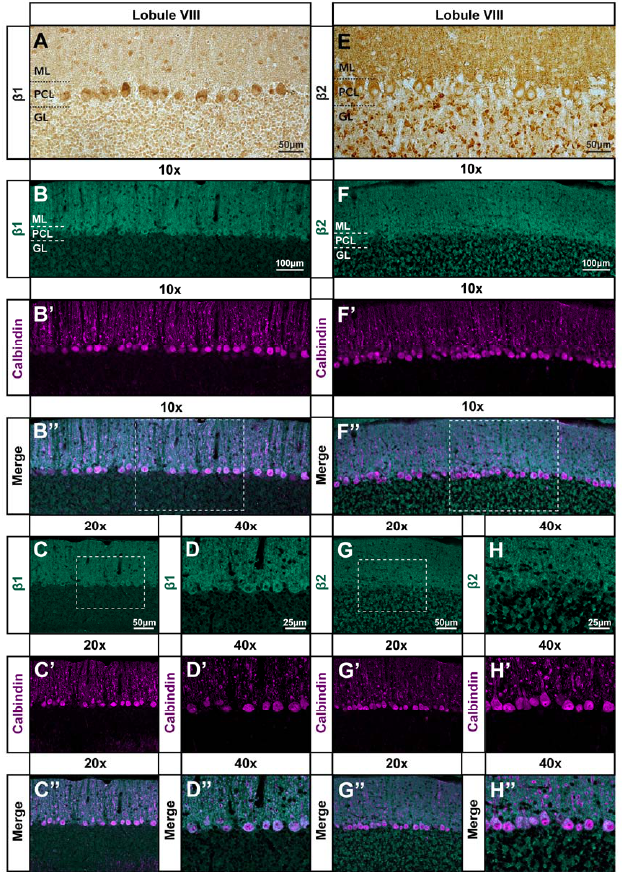
Figure 5. The β 1 and β 2 adrenergic receptor antibody signal is expressed throughout the cerebellar cortex. ( A , E ) Paraffin staining of a coronal section cut through lobule VIII of the cerebellar cortex in control mice (N = 8) showing β 1 ( A ) and β 2 ( E ) adrenergic receptor antibody staining in brown. Purkinje cell somata are positioned in the Purkinje cell layer (PCL) underneath the molecular layer (ML), and directly below the PCL lies the granular layer (GL) containing granule cells and various classes of interneurons. The β 1 and β 2 signal is expressed throughout all three layers of the cerebellar cortex. Scale bar is 50 µ m. ( B – B” , F – F” ) Free-floating fluorescence double staining of the same coronal view of lobule VIII with β 1 ( B ) and β 2 ( F ) antibody signal in green, calbindin expression in Purkinje cells in magenta ( B (cid:48) , F (cid:48) ), and the overlay of β 1 or β 2 and calbindin ( B” , F” ). Co-localized β 1 or β 2 and calbindin expression appears as a brighter, whitish hue. Dotted outlines in B” and F” indicate the areas from which the higher magnification images in ( C – C” , G – G” ) were taken. Scale bar is 100 µ m. ( C – C” , G – G” ) Higher magnification image of the dotted outlined areas from ( B” , F” ) showing β 1 ( C ) and β 2 ( G ) signal expression in green, calbindin expression in Purkinje cells in magenta ( C (cid:48) , G (cid:48) ), and the overlay of β 1 or β 2 and calbindin ( C” , G” ). Dotted outlines in ( C , G ) indicate the area from which the higher magnification images in ( D – D” , H – H” ) were taken. Scale bar is 50 µ m. ( D – D”, H – H” ) Even higher magnification image of the dotted outlined areas from ( C , G ) showing β 1 ( D ) and β 2 ( H ) signal expression in green, calbindin expression in Purkinje cells in magenta ( D (cid:48) , H (cid:48) ), and the overlay of β 1 ( D” ) or β 2 ( H” ) and calbindin. At these higher magnifications, the co-localization of β 1 or β 2 and calbindin expression is more easily appreciated. Scale bar is 25 µ